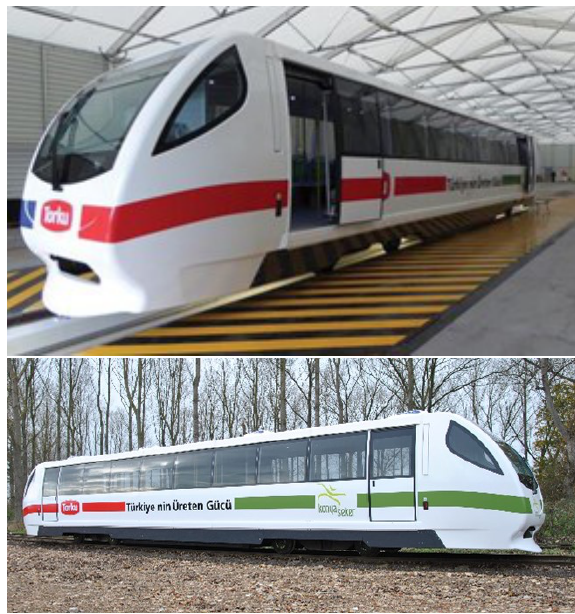
Figure 9. Very Light Rail for export to Turke